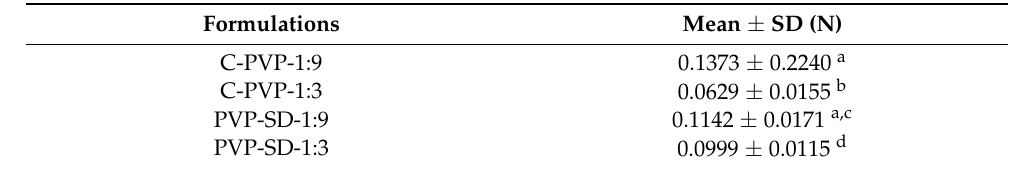
Table 5. Bioadhesion strength of the films in porcine skins. The same letters indicate no statistical difference between the samples (T-test, p > 0.05).